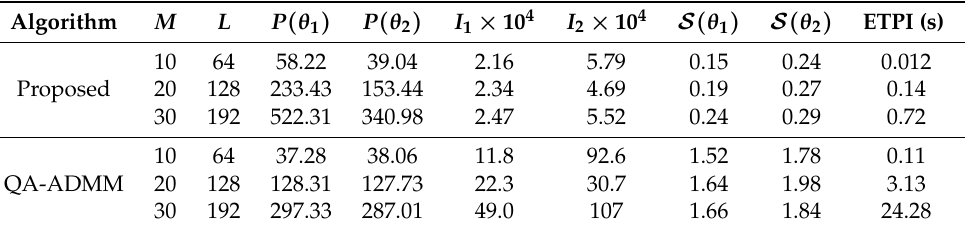
Table 2. The performance of each algorithm in jointly designing the transmit beampattern and AWs with spectral compatibility and similarity.